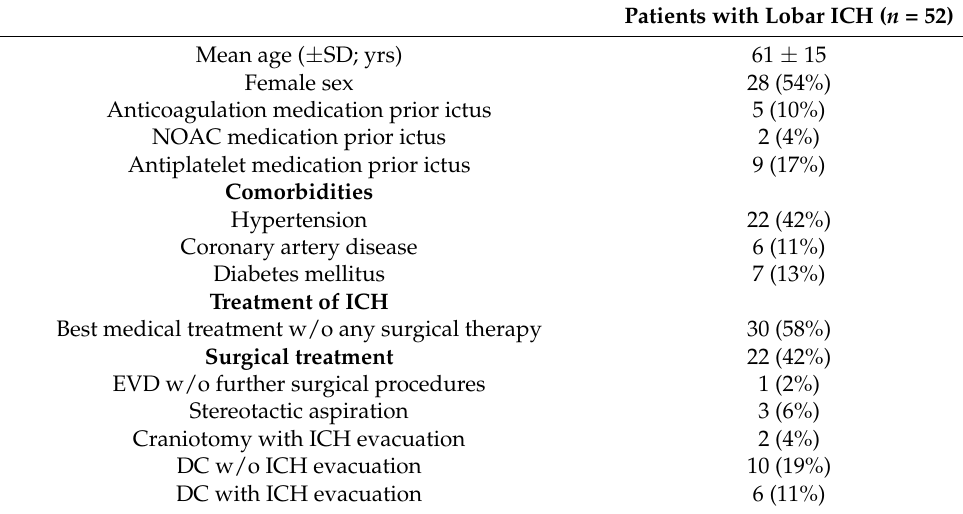
Table 1. Patients ’ characteristics. Table 1. Patients’